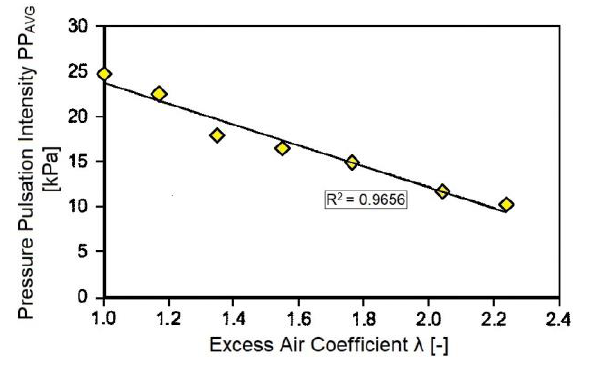
Fig. 2. Compression ratio influence on pressure pulsation intensity of CFR engine [28] Fig. 3. Excess air influence on pressure pulsation intensity